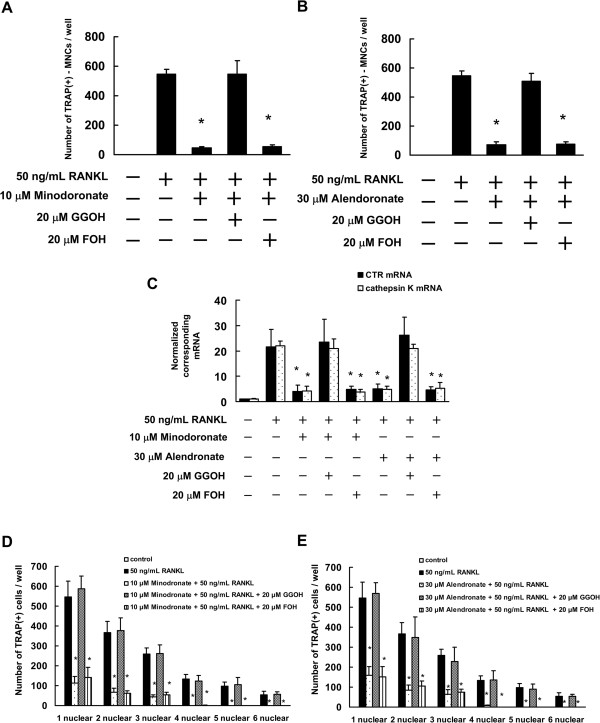
Minodronate and alendronate inhibited osteoclast formation via suppression of GGPP biosynthesis in RAW264.7 cells. RAW264.7 cells were pretreated with 20 μM FOH or 20 μM GGOH for 4 h and then treated with 10 μM minodronate or 30 μM alendronate, and 50 ng/mL RANKL for 7 days. Cultures were fed every 2 days by replacing with 500 μL of fresh medium, with or without minodronate, alendronate, RANKL, FOH, and GGOH. (A, B) Inhibitory effect of mevalonate pathway intermediates FOH or GGOH on the inhibition of osteoclast formation by minodronate (A) or alendronate (B). Cultures were fixed and stained for TRAP-positive multinucleated cells, and the number of cells per well was counted. These results are representative of 5 independent experiments. *P < 0.01 compared to 50 ng/mL RANKL administration. (C) CTR and cathepsin K mRNA expression in RAW264.7 cells that were treated with minodronate or alendronate along with FOH or GGOH. Total RNA was extracted, and the CTR and cathepsin K mRNA levels were determined by real-time PCR. The results are expressed as the ratio of treated to control samples after normalization to GAPDH mRNA levels. The results are representative of 4 independent experiments. *P < 0.01 compared to 50 ng/mL RANKL administration. (D, E) Cultures were fixed and stained for TRAP-positive cells, and the number of cells per well was counted. These results are representative of 4 independent experiments. *P < 0.01 compared to 50 ng/mL RANKL administration.